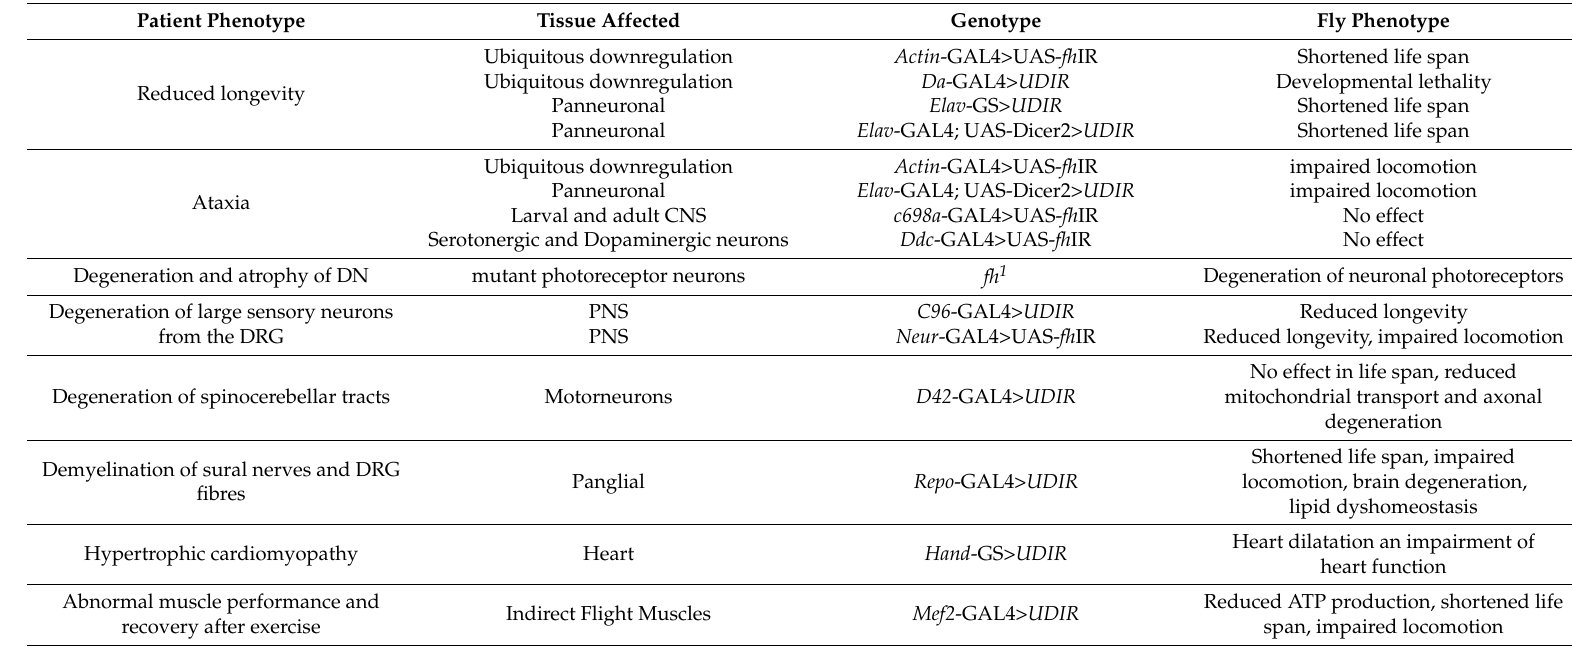
Table 1. Comparison of physiological hallmarks of FRDA in patients and phenotypes observed in FRDA fly